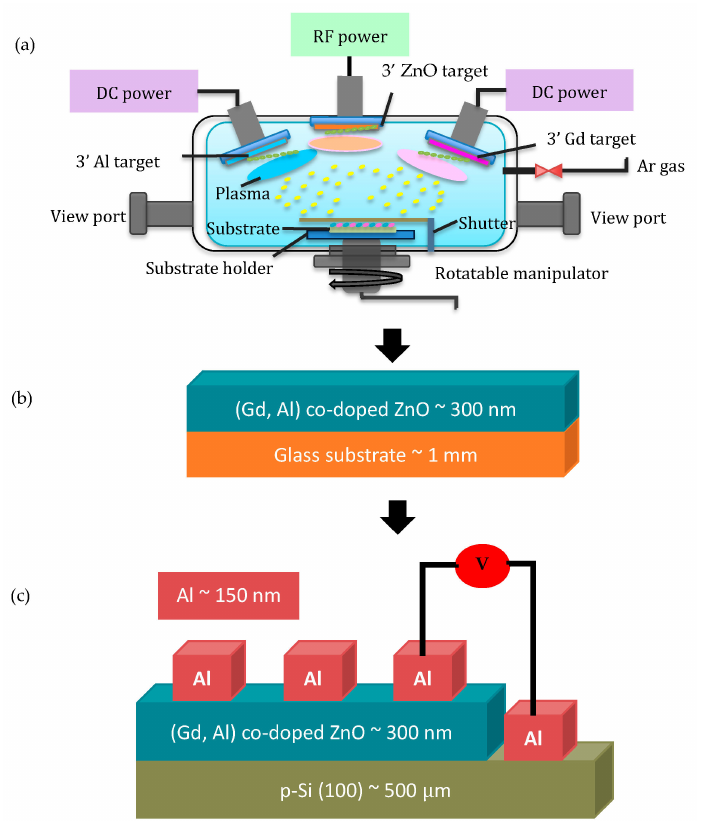
Figure 1. ( a ) Preparation of (Gd, Al) co-doped ZnO films, ( b ) deposited (Gd, Al) co-doped ZnO film, and ( c ) the Al/n- ZnO-based DMS/p-Si heterojunction structure.